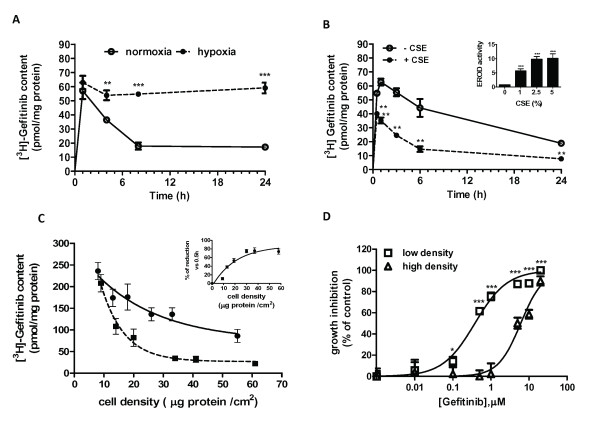
Conditions affecting gefitinib metabolism: hypoxia, cigarette smoke extract and cell density. A) H322 cells were incubated with 0.1 μM [3H]gefitinib under normoxia or hypoxia for the indicated times. Values given of gefitinib content, expressed as pmol/mg of protein, are the means (± SD) of four independent determinations (**P < 0.01; ***P < 0.001). B) Calu-3 cells were treated for 24 h with 2.5% of CSE and then exposed to 0.1 μM [3H]gefitinib for the indicated times. Values given are the means (± SD) of three independent determinations (**P < 0.01; ***P < 0.001). Inset: EROD assay performed in cells untreated or treated for 24 h with 1, 2.5 or 5% CSE expressed as pmol Res/mg protein/min. C) Calu-3 cells were seeded at different cell density (from 7000 to 70000 cells/cm2) and after 24 h incubated for 0.5 h (●) or 24 h (■) with 0.1 μM [3H]gefitinib. Then, the intracellular [3H]gefitinib content was determined and plotted versus final cell density expressed as μg protein/cm2. Inset: values are expressed as % of reduction versus 0.5 h value. D) Calu-3 seeded at low and high density (7000 and 70000 cells/cm2 respectively)were exposed for 72 h to different concentrations of gefitinib. Cell growth was assessed using crystal violet staining. Data are expressed as percent inhibition of cell proliferation versus control cells. The mean values of three independent measurements (± SD) are shown (*P < 0.05; ***P < 0.001).